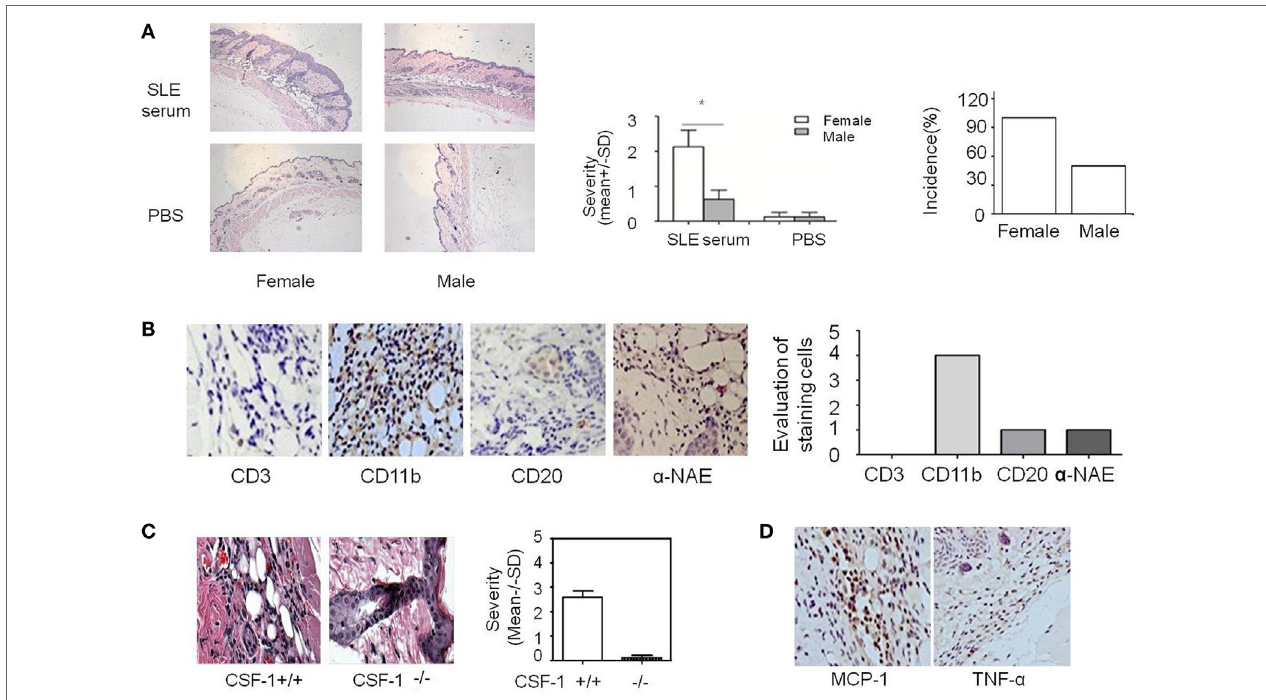
FigUre 1 | Analysis of systemic lupus erythematosus (SLE) serum-induced skin inflammation in mice and the role of monocytes in this progress. (a) Representative histopathological photomicrograph of the severity and incidence of skin inflammation in female and male C57BL/6 mice sacrificed 3 days after intradermal inoculation of serum (100 µl) from SLE patients ( n = 8 per group). H&E, original magnification 20 × . (B) Immunohistochemical staining for CD3, CD11b, CD20, and α -NAE expression in skin lesions of C57BL/6 mice 3 days after intradermal inoculation of serum (100 µl) from SLE patients (the scoring system: 0, no positive cells; 1, 1–5 positive cells; 2, 6–10 positive cells; 3, 10–20 positive cells; 4, > 20 positive cells in a field). (c) Severity and picture of SLE serum-induced skin inflammation in female Csf-1 − / − mice and wild-type mice ( n = 5 per group) 3 days after intradermal inoculation of serum (100 µl) from SLE patients. (D) Immunohistochemical staining for MCP-1 and TNF- α expression in skin lesions of C57BL/6 mice 3 days after intradermal inoculation of SLE serum. * P <